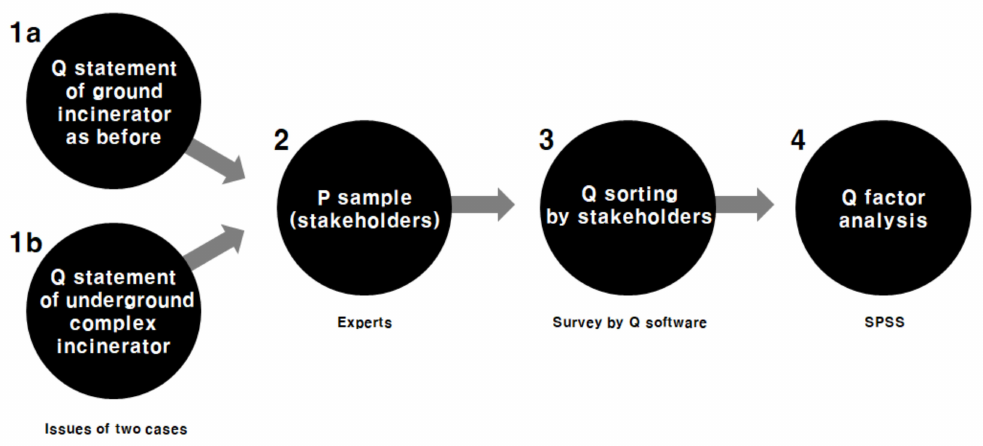
Figure 1. The Q-methodology